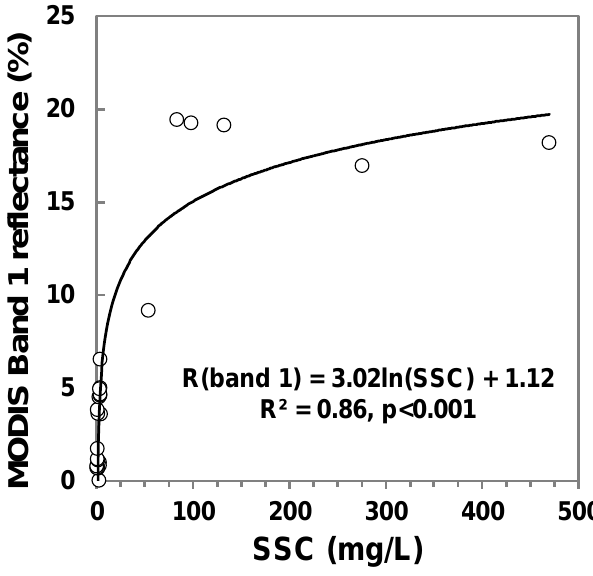
Fig. 4. Empirical relationship between field SSC and simultaneous MODIS band 1 reflectance, with 22 samples from Kangerlussuaq Fjord, a land-terminating glacier outlet, and 3 samples from Equip Sermia, a marine-terminating glacier outlet ( R 2 = 0 . 86, p < 0 .